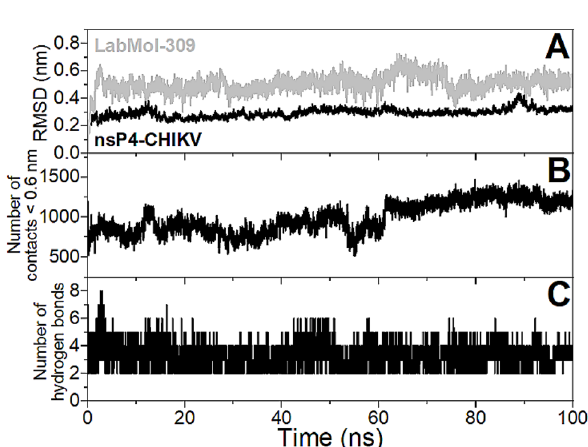
Figure 4. Molecular interactions of LabMol-309 and nsP4-CHIKV, predicted by docking calculations. ( A ) 3D interactions of LabMol-309 and nsP4-CHIKV residues. Hydrogen bonds are shown as gray dashed lines, and cation–π interactions are shown in green dashed lines. Oxygen, nitrogen and hydrogen atoms are shown in red, blue and white, respectively. Carbon atoms of LabMol-309 and protein residues are shown in purple and gray, respectively. Catalytic residues of the GDD triad are highlighted in bold. ( B ) 2D interaction diagram of LabMol-309 and nsP4-CHIKV residues. Hydrogen bonds are shown as gray dashed lines, and cation–π interactions are shown in green dashed lines. Catalytic residues of the GDD triad are highlighted in blue.